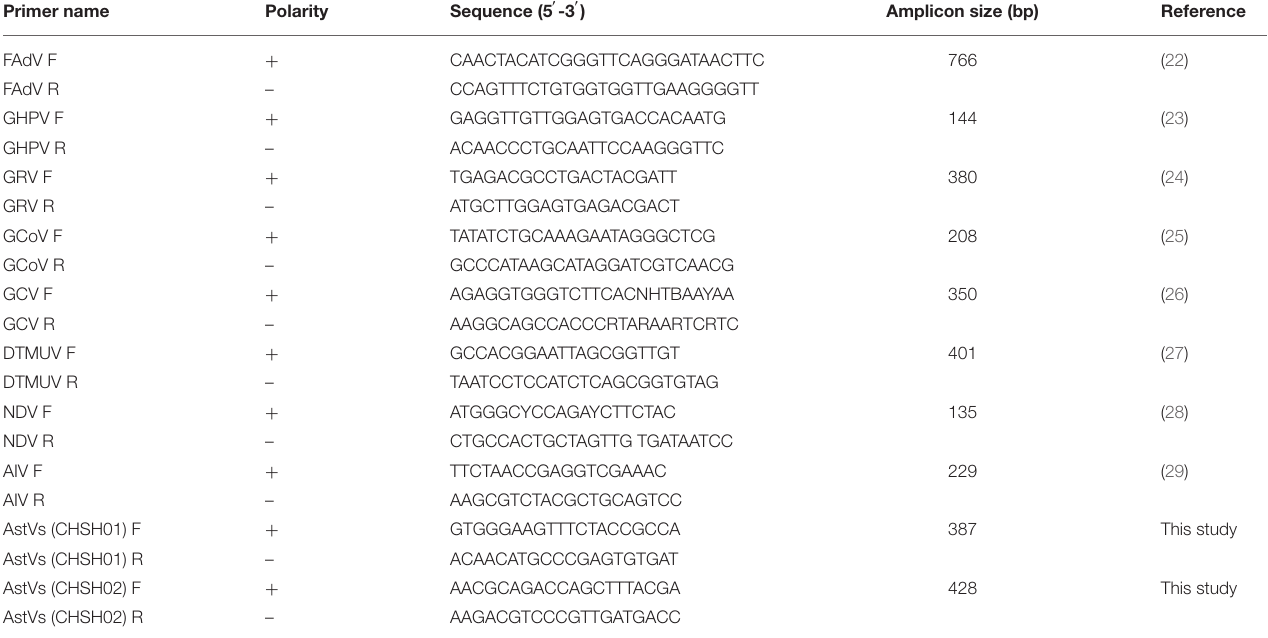
TABLE 1 | Primers used in this study for detection of the